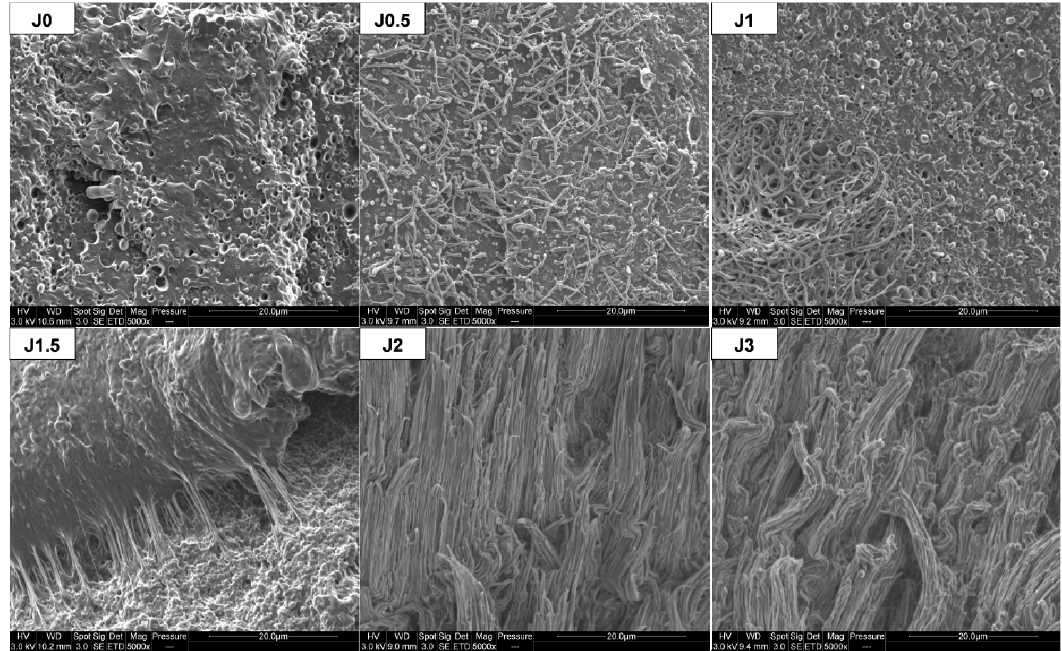
Figure 9. SEM observations of tensile fracture surface for injected PLA80-Jx.